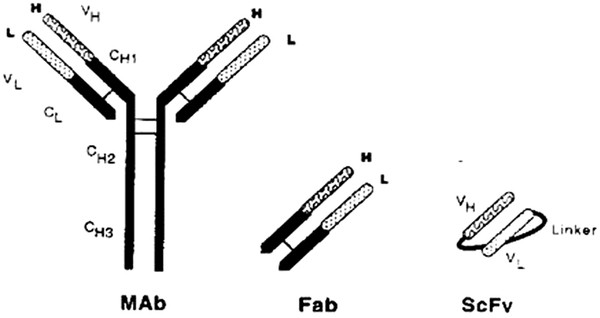
Map of VH-linker-VL.